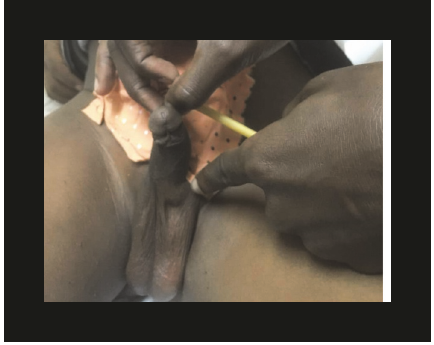
Figure 11: Physical exam showing location of stone (case 3).